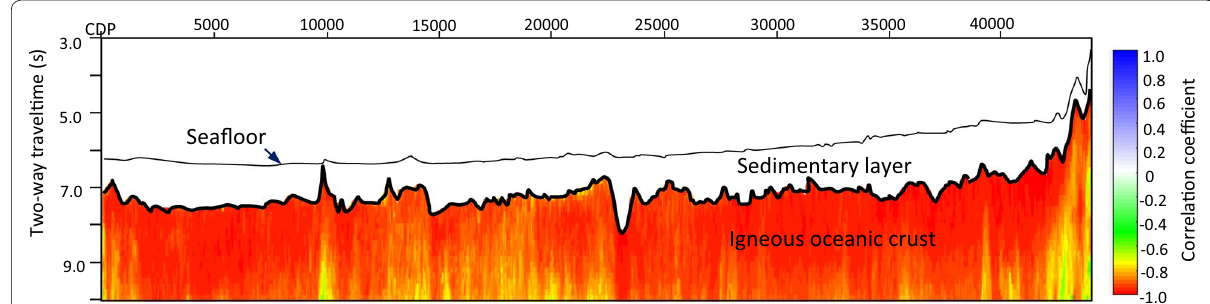
Fig. 5 Mapping of correlation coefficient on linear approximation to compute gradient p in the Eq. (3). Almost all of the correlation coefficients are smaller than 0.8, showing high negative correlation. Only a very few locations have around −